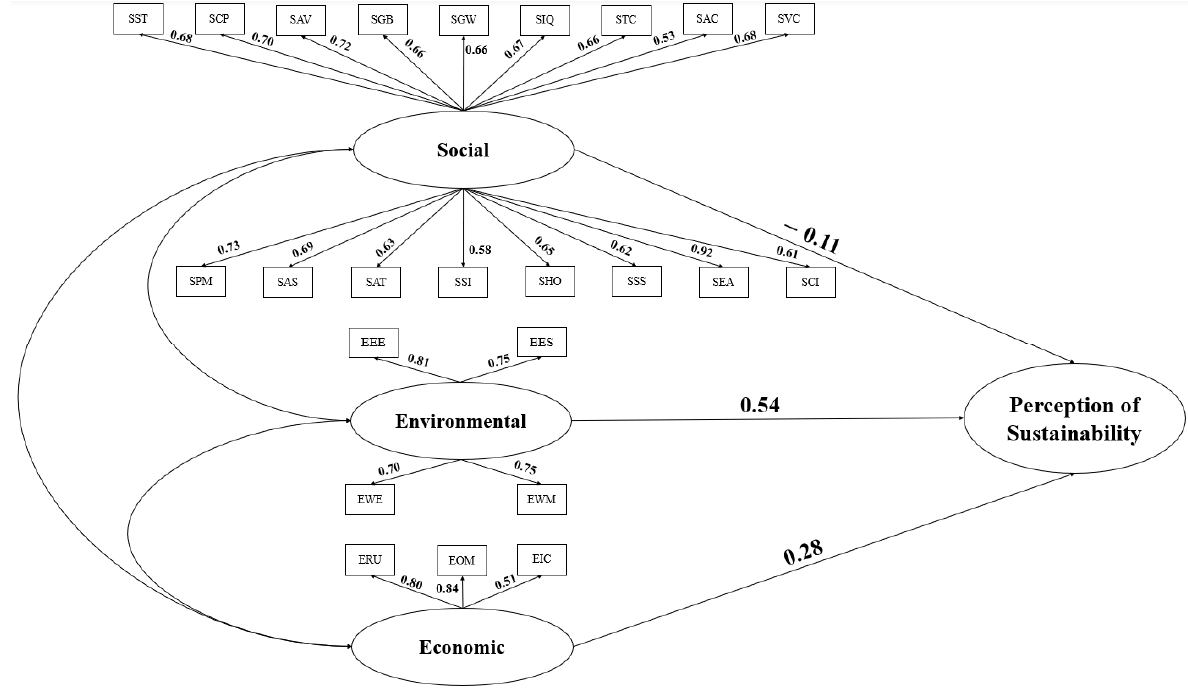
Figure 4. Initial Structural Equation Model .